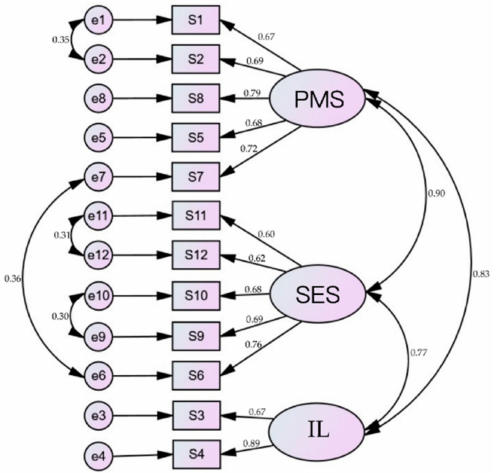
Figure 1. Community-dwelling older adults’ self-healing model. Confirmatory factor analysis based on 12 items and three factors. Note. PMS = physical and mental state; SES = socioeconomic and environmental state; IL = independent